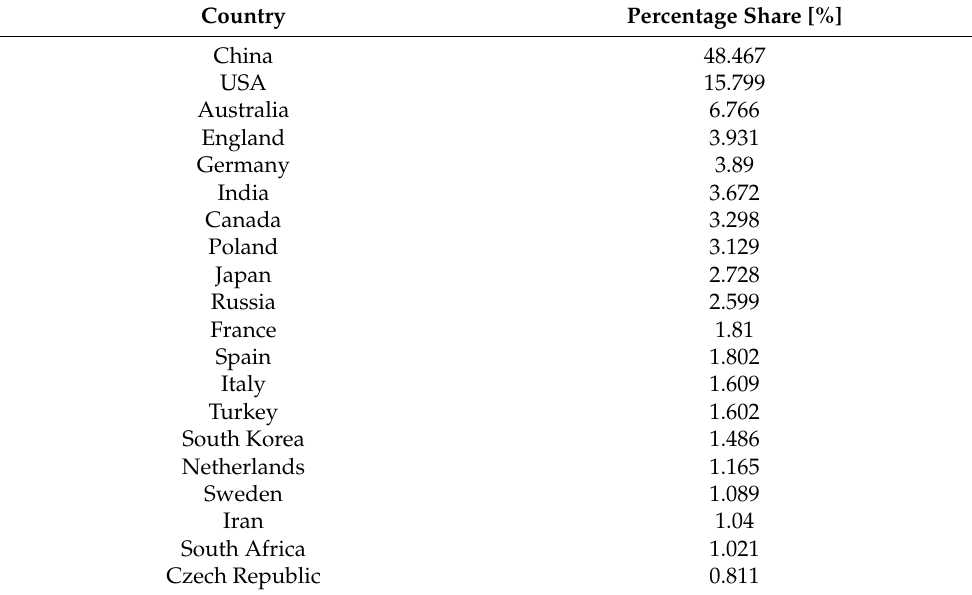
Table 4. Top 20 countries with the highest number of